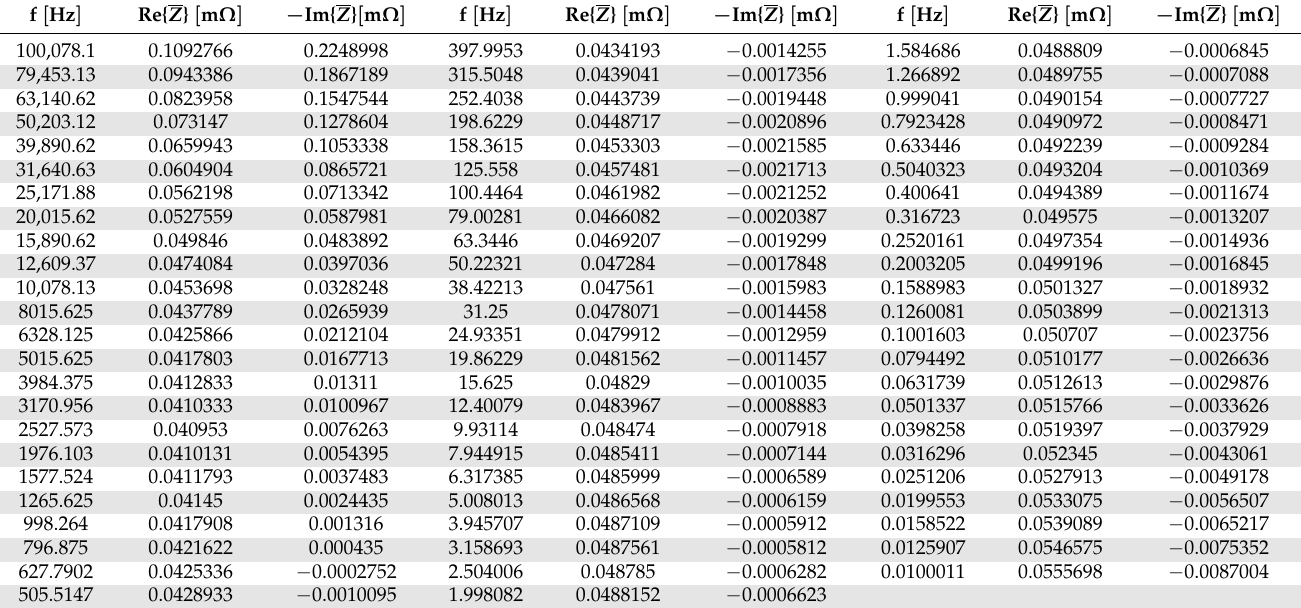
Table A2. EIS data for LG Chem MJ1 at an SOC of 50%.